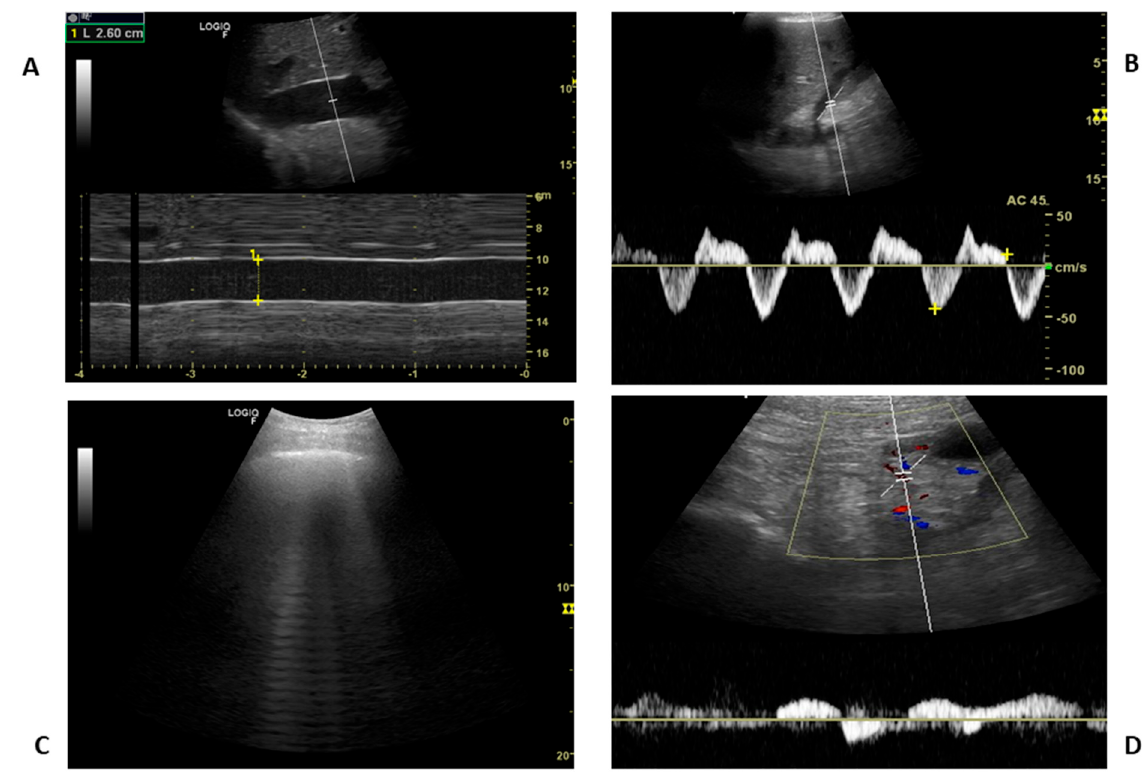
Figure 4. A combined approach of IVC ( A ), suprahepatic veins ( B ), lung ( C ) and renal veins ( D ) allows a more comprehensive assessment of the extent and severity of systemic venous congestion. Note that the IVC appears dilated and almost motionless during breaths (IVC max 2.6 cm, cIVC close to